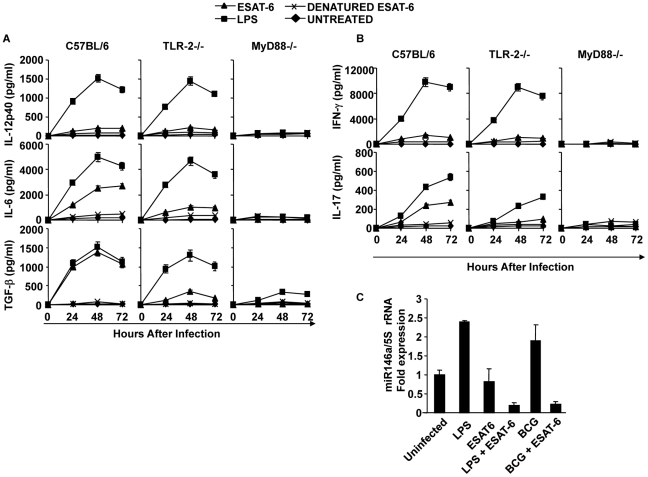
ESAT-6 induces IL-6 and TGF-β in DCs in a TLR-2- and MyD88-dependent manner.DCs from wt, TLR-2-/-, or MyD88-/- mice were treated with ESAT-6 protein, LPS, or denatured ESAT-6 protein, or untreated. Supernatants were harvested at different time points and cytokines were measured. (A) IL-12p40, IL-6, and TGF-β in supernatants of the cultured DCs. (B) Production of IFN-γ and IL-17 by OT-II TCR Tg CD4+ T cells co-cultured with DCs that were treated with ESAT-6 protein and LPS. (C) Quantitative expression of miR146a profile after LPS and ESAT-6 treatment in DCs. Results presented in (A) and (B) are representative of six independent experiments and results presented in (C) are representative of three independent experiments.